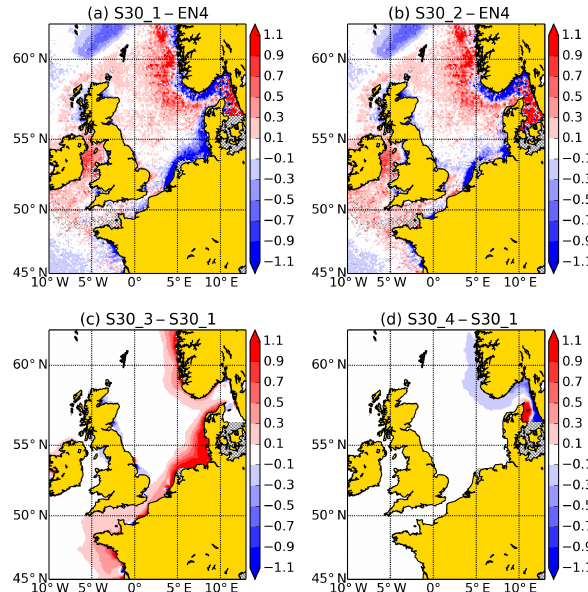
Figure 13. Comparing SSS using climatological river and Baltic in- puts against E-HYPE rivers and IoW Baltic. Panel (a) shows 33 SH levels with E-HYPE rivers and IoW Baltic (S30_1) vs. EN4. Panel (b) shows 33 SH levels with climatological rivers and climatolog- ical Baltic (S30_2) vs. EN4. Panel (c) shows climatological rivers minus E-HYPE rivers (S30_3–S30_1). Panel (d) shows climatolog- ical Baltic – IoW Baltic (S30_4–S30_1).